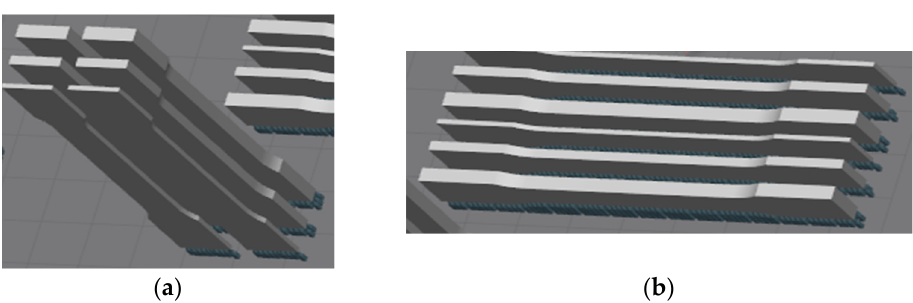
Figure 1. Investigated parts printed with different orientation with respect to the machine platform ( a ) Part orientation in Z direction; ( b ) Part orientation in XZ direction.